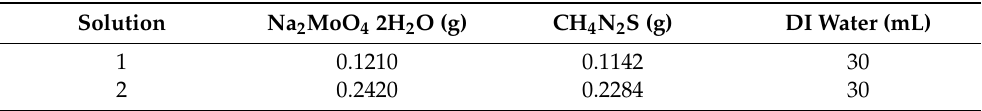
Table 1. Different concentrations of precursors used for synthesizing the CNT–MoS 2 composite network.